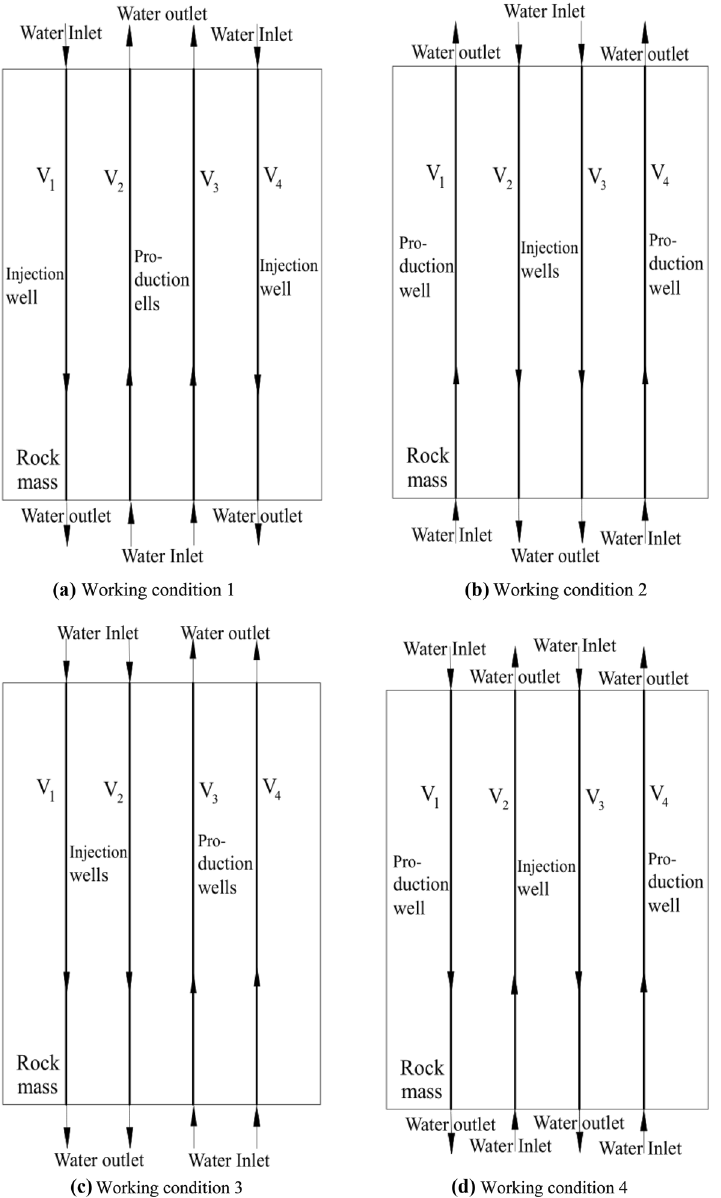
Figure 3. Model calculation conditions.